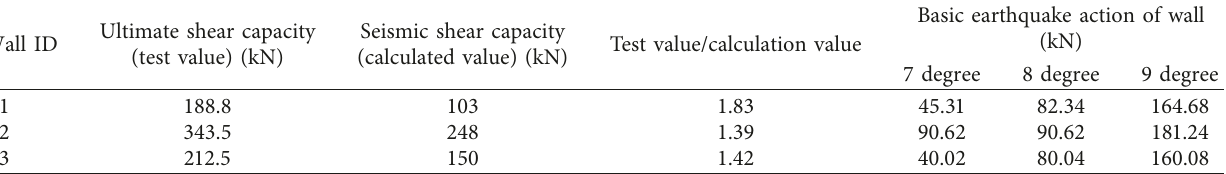
Table 11: Calculated and experimental values of shear strength of